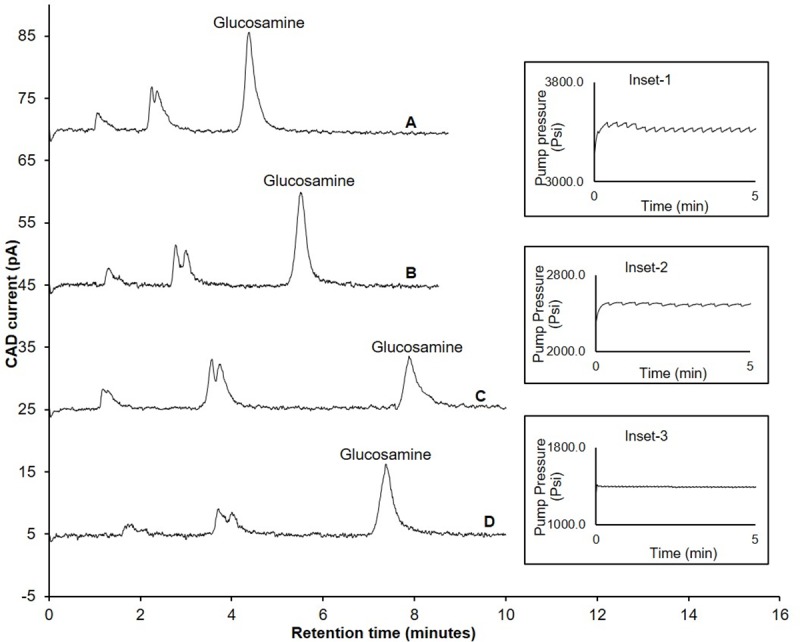
Influence of flow rate and temperature on backpressure and retention time of glucosamine hydrochloride.A) Retention time of glucosamine and backpressure of the column (Inset-1) when flow rate was 0.5 mL/min and column temperature was 25°C; B) Retention time of glucosamine when flow rate was 0.4 mL/min and column temperature was 25°C; C) Retention time of glucosamine and backpressure of the column (Inset-2) when flow rate was 0.3 mL/min and column temperature was 25°C; D) Retention time of glucosamine and backpressure of the column (Inset-3) when flow rate was 0.3 mL/min and column temperature was 40°C; Experimental conditions: ZIC-HILIC column (150, 4.6 mm), 200 Å, 5 μm; mobile phase containing 65% acetonitrile and 100 mM ammonium acetate; column temperature (as specified above); detection with Corona-CAD; flow rate- (as specified above); injection volume 5 μL.